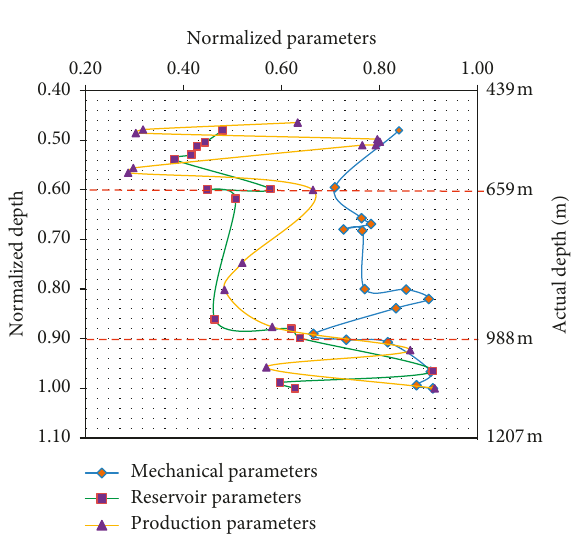
Figure 9: The fitted curve using the normalization method using three different parameter